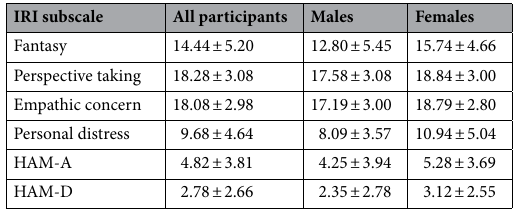
Table 1. Scores on psychological instruments (IRI subscales, HAM-A and HAM-D) for all subjects, males and females (mean ± standard